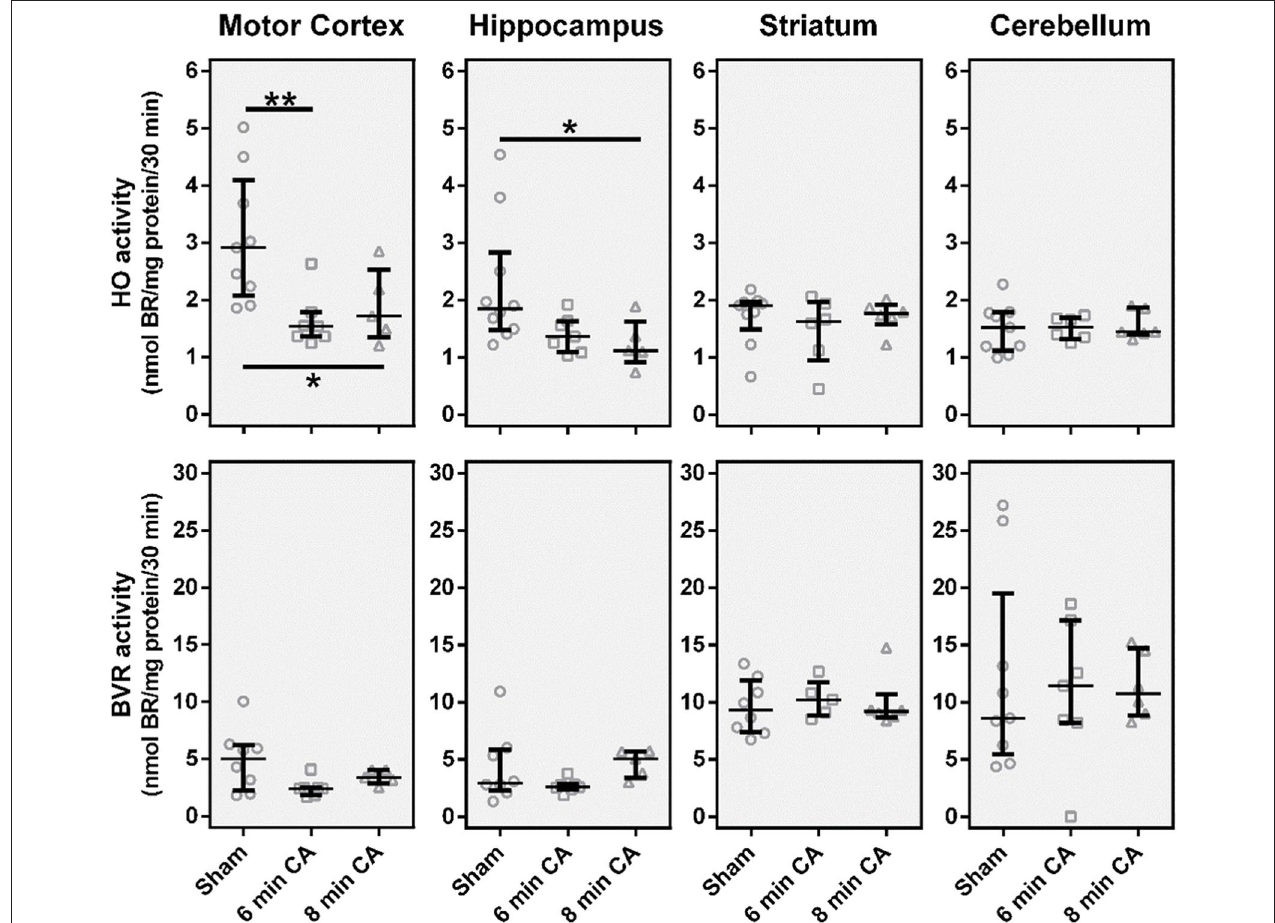
FIGURE 3 | Catalytic activities of the heme degradation pathway enzymes, HO and BVR, in brain regions 2 weeks after cardiac arrest (CA) (6 or 8min) and resuscitation. Animals were subjected to CA for 6min (CA 6min) or 8min (CA 8min) or sham operated, as outlined in Materials and Method section. Brain regions were analyzed for enzyme activity by measuring the capacity of homogenized tissue to convert heme (HO activity) or biliverdin (BVR activity) into bilirubin within 30min. The obtained amount of BR was corrected for the underlying protein concentration and enzyme activity is given in nmol BR formed per mg protein in 30min (nmol BR/mg protein/30min). Data are shown for single animals (gray open symbols) in each group: sham (instrumented animals, open circles, n = 9), rats subjected to CA for 6min (CA 6min, open squares, n = 7) or 8min (CA 8min, open triangles, n = 6), indicating additionally group medians (thin black line) and 1st and 3rd quartiles (bold black lines). Differences between groups are indicated (one-way non-parametric ANOVA (Kruskal Wallis) Bonferroni-corrected; * p < 0.05; ** p <